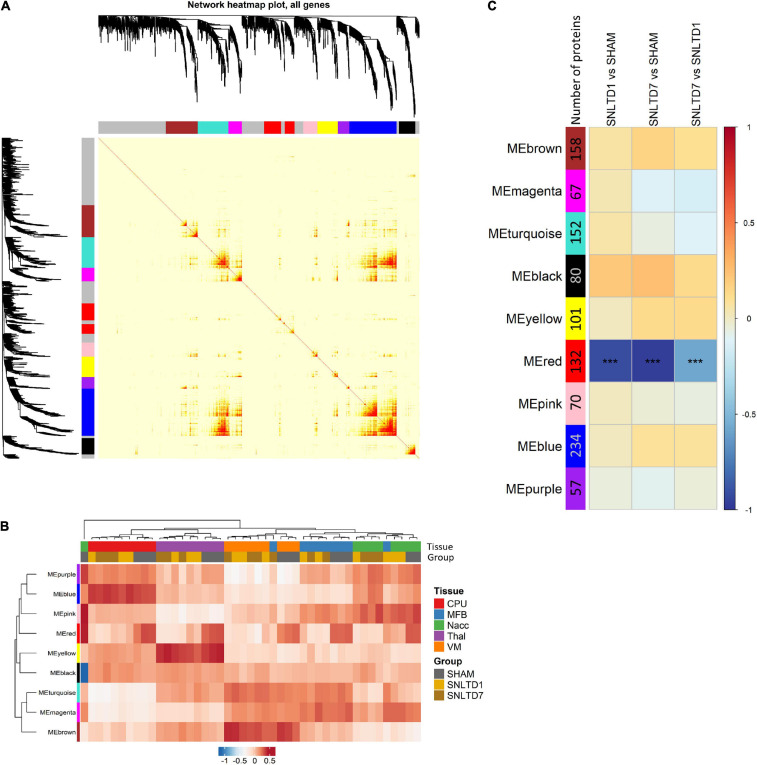
Weighted gene coexpression network analysis (WGCNA). (A) Topology overlap matrix showing nine modules represented by different colors. The gray color represents 538 background proteins that were not attributed to any of the nine modules. (B) A heatmap of module eigengenes (MEs) summarizing the various identified modules. ME, calculated for each module, is a synthetic gene defined as the first principal component (PC1 from PCA) of the expression matrix of the corresponding module. (C) A module–trait relationship plot showing Pearson correlation between the MEs from various modules and the following binary comparisons: SNLTD1 vs. SHAM, SNLTD7 vs. SHAM or SNLTD7 vs. SNLTD1, regardless of tissue of origin.